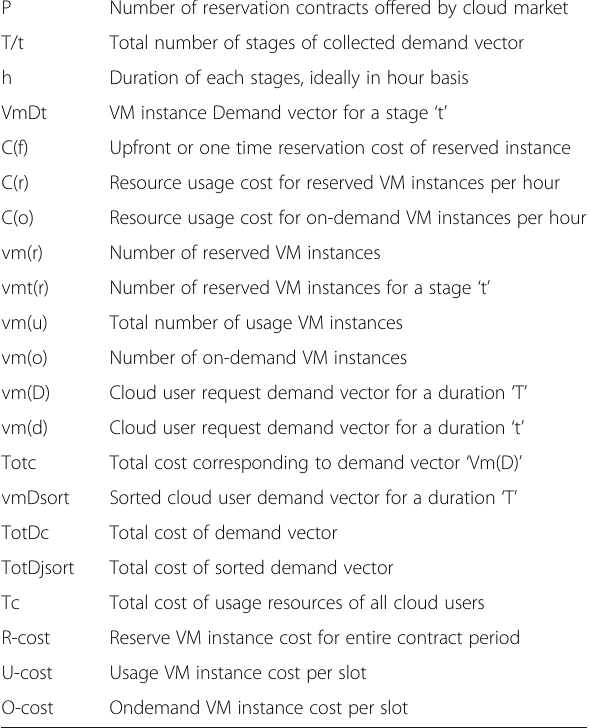
Table 6 Notation